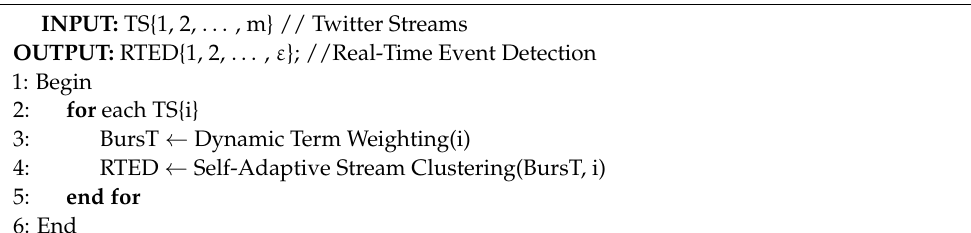
Algorithm 1 1st Pass real-time event